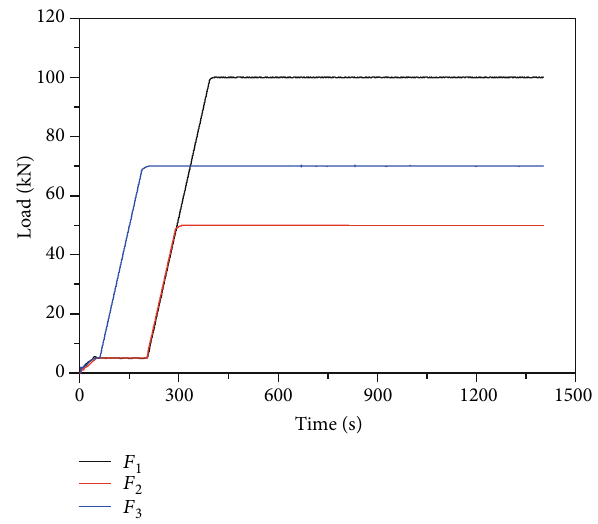
Figure 3: Typical loads applied to a cubic specimen.